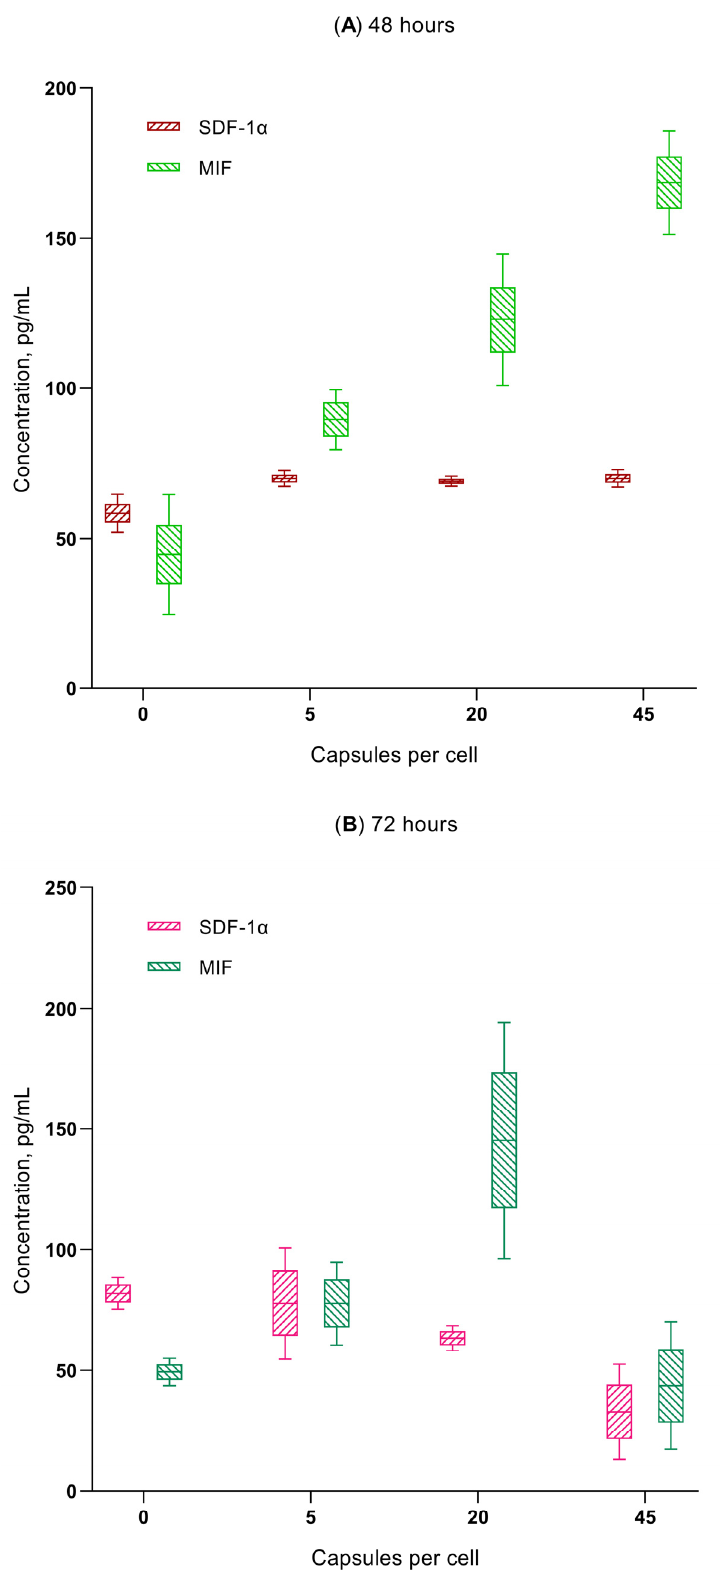
Figure 6. In vitro secretion of MIF and SDF-1 α chemokines by hAMSCs after 48 ( A ) and 72 h ( B ) of microcapsules internalization in different doses. Mean; Box: Mean ± SE; Whiskers: Mean ± SD.